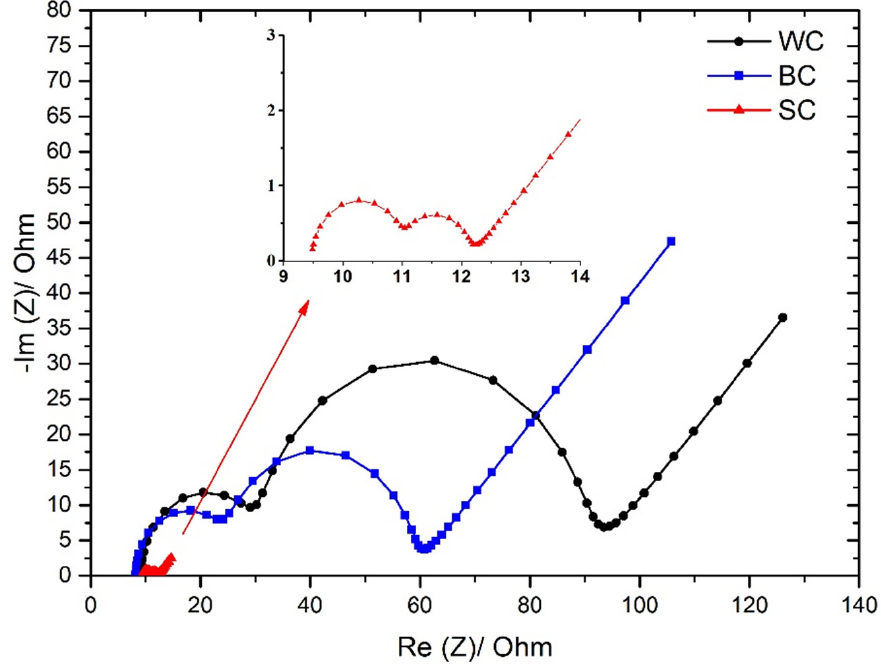
Figure 8. Nyquist diagrams of leachate-fed MFC for three different cathode configurations (WC , BC and SC ).